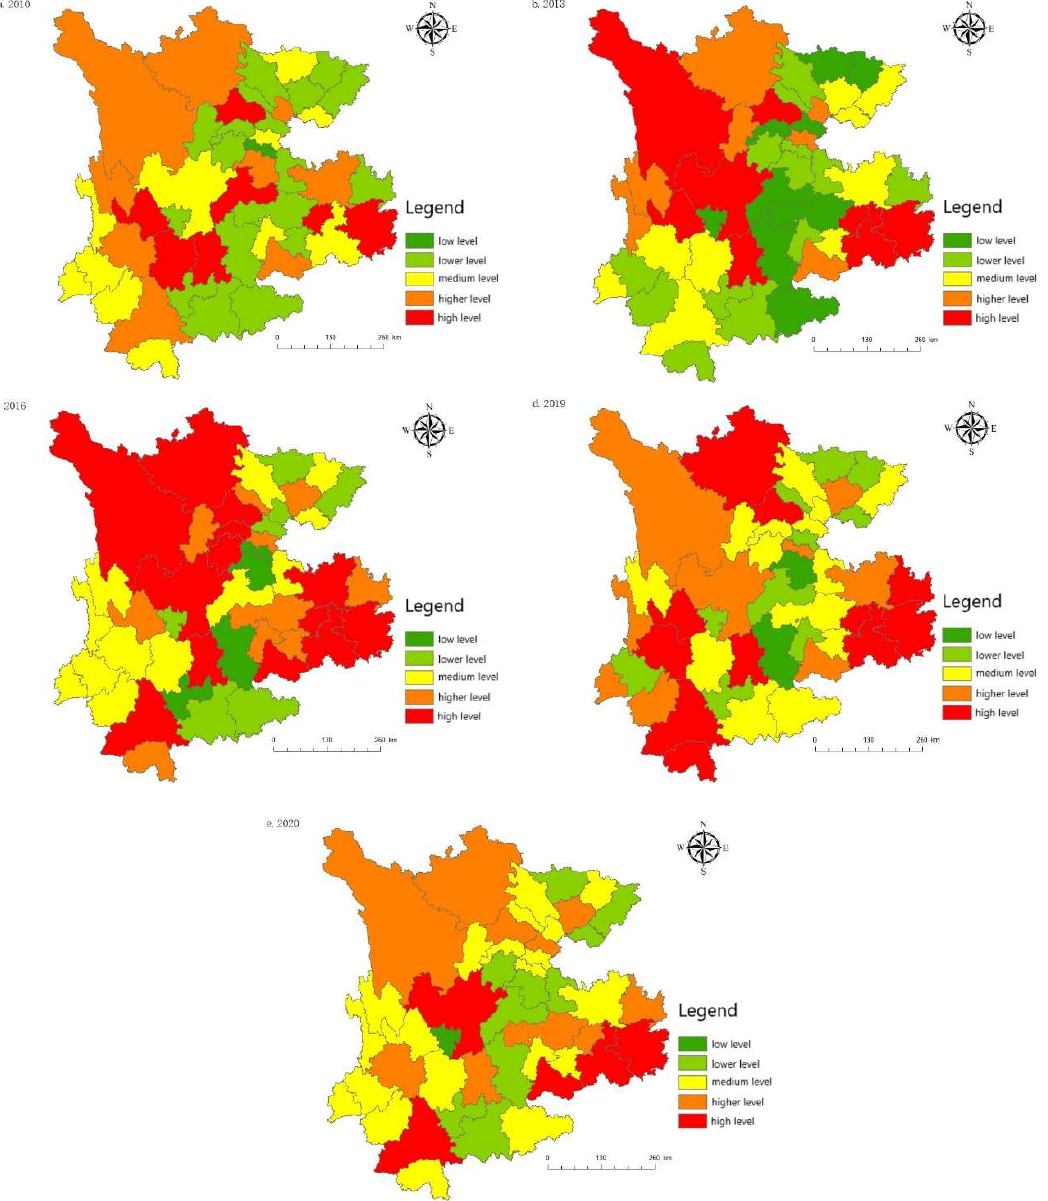
Figure 10. Spatial distribution of the ecological environment development level: ( a ) The ecological environment development level in 2010; ( b ) The ecological environment development level in 2013; ( c ) The ecological environment development level in 2016; ( d ) The ecological environment development level in 2019; ( e ) The ecological environment development level in 2020.